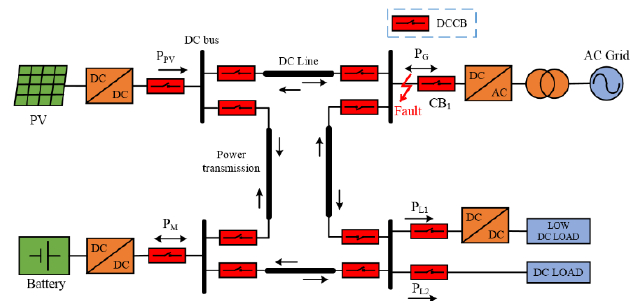
Figure 1. Structure of typical DC microgrid.